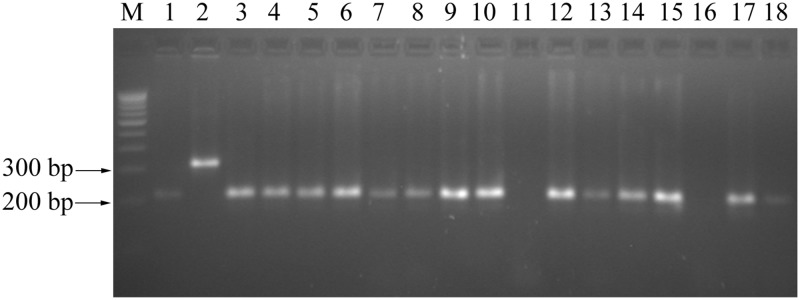
PCR amplification using genic-SSR marker VMgSSR-30 in 18 black gram genotypes.